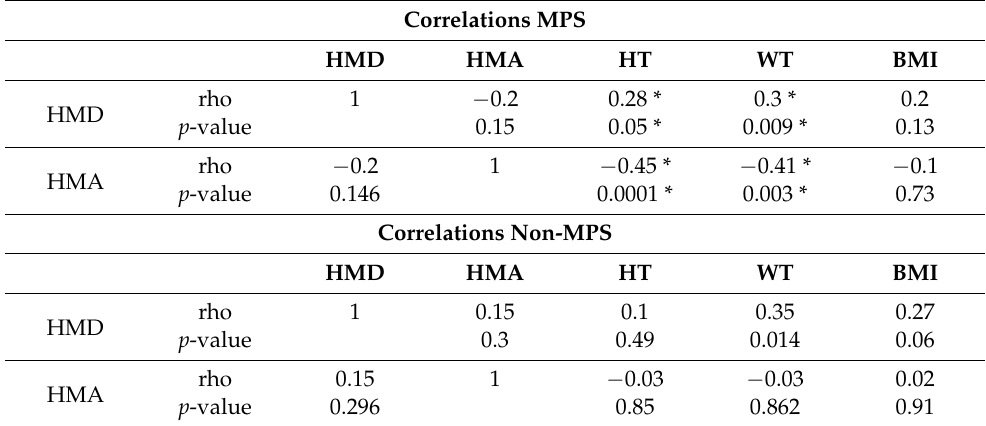
Table 5. Pearson correlation between HMA, HMD, height, weight, and BMI in both the MPS and non-MPS